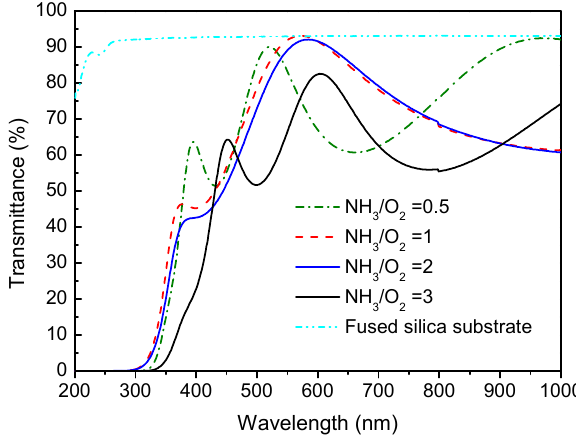
Figure 9. UV-vis transmittance of the films fabricated under various NH 3 / O 2 gas ratios. Figure 9. UV - vis transmittance of the films fabricated under various NH 3 /O 2 gas ratios.